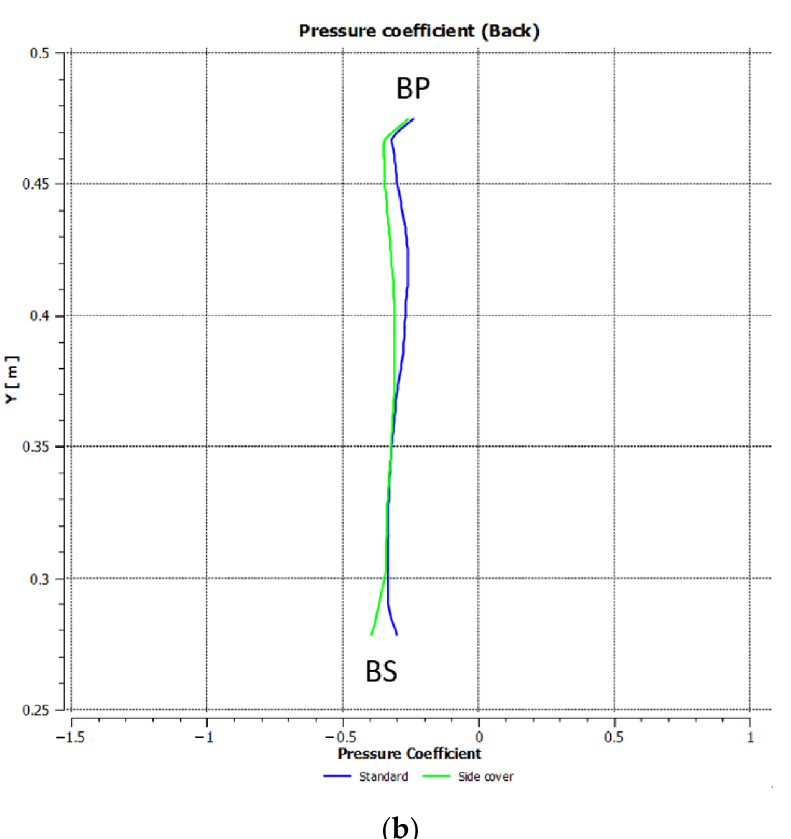
Figure 30. ( a ). Pressure acting on the back surface, z = 0.12 m, ψ = 30 degrees. (Left: without side covers; Right: with side covers; BP: Back-Port side, BS: Back-Starboard). ( b ). Comparison of pressure acting on the back surface, z = 0.12 m, ψ =30 degrees.